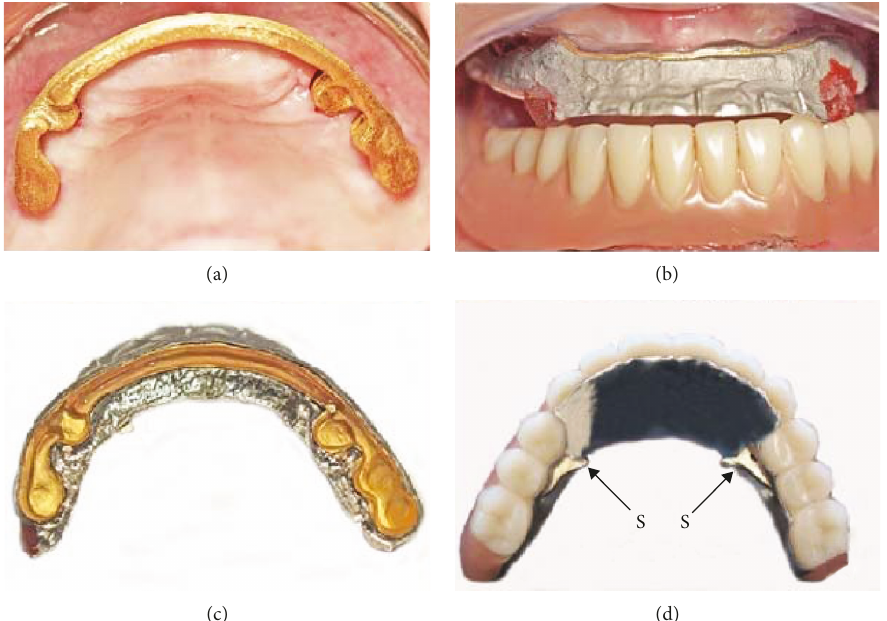
Figure 8: (a) ELMES try-in; (b) veri fi cation of the occlusal relationship with the framework in; (c) ELMES fi xed in the framework; (d) external view of the metal framework (S: swivel-type lock